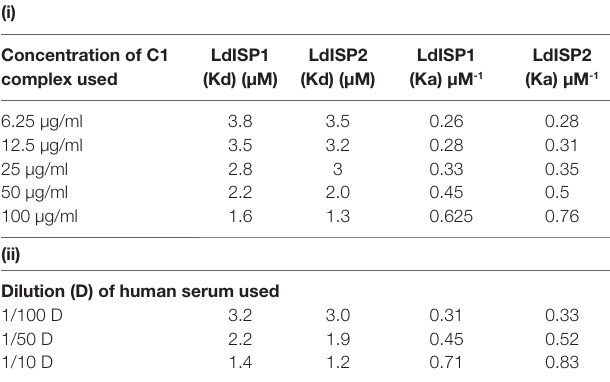
TaBle 2 | Binding affinity of LdISP1 and L. donovani inhibitor of serine peptidases 2 (LdISP2) with (i) C1 complex and (ii) serum MBL-associated serine proteases.